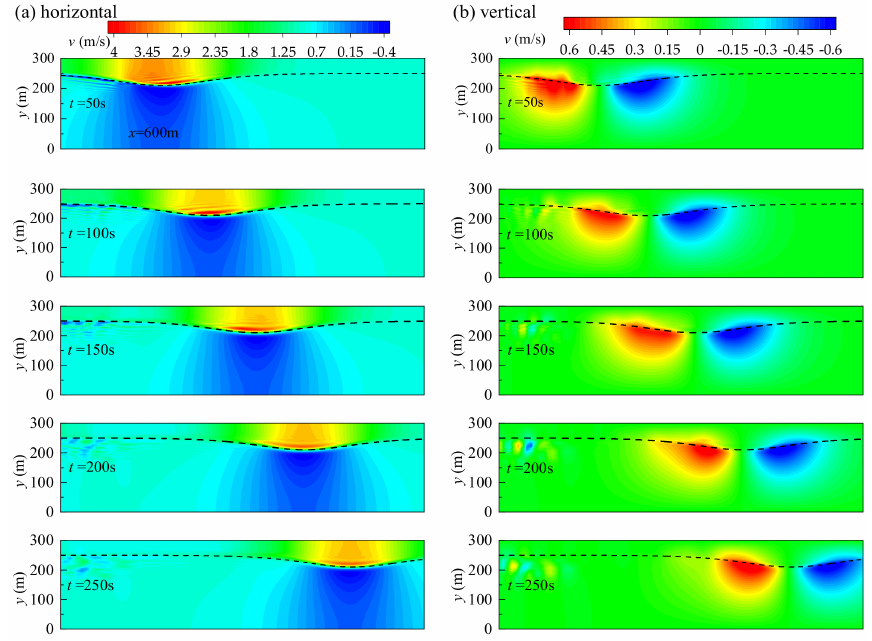
Figure 7. Velocity fields of the ISWs for Cases A3: ( a ) horizontal component; ( b ) vertical